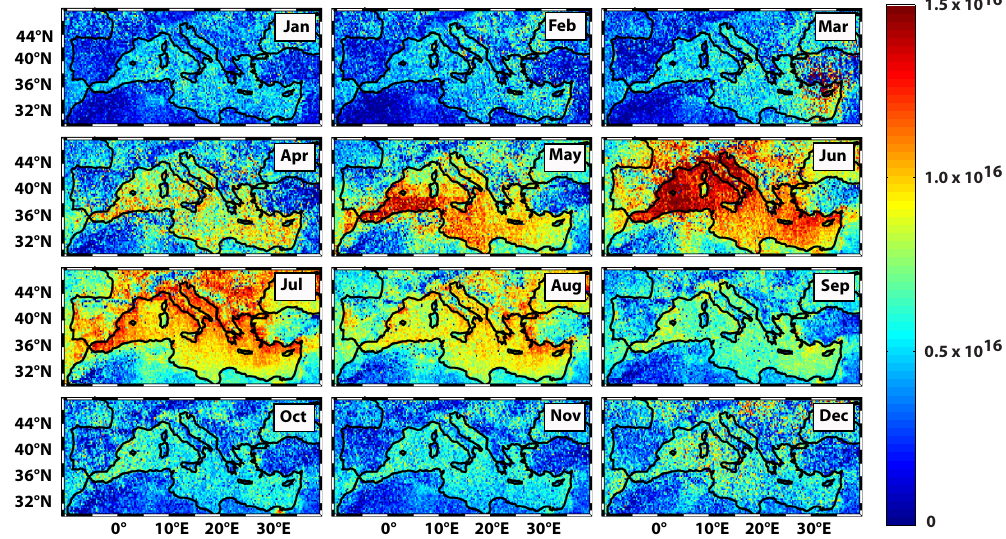
Fig. 1. Monthly averaged (from 2005 to 2007) OMI retrieved formaldehyde vertical columns in units of molecules cm − 2 .